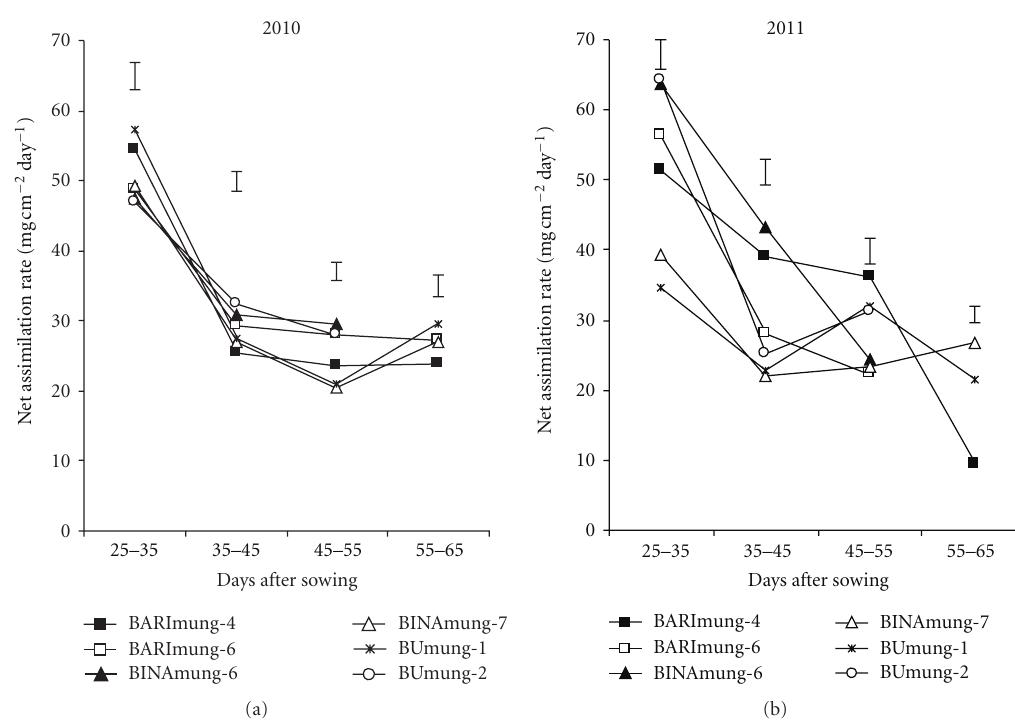
Figure 5: Showing net assimilation rate of four mungbean genotypes at di ff erent ages. Vertical bars represent LSD